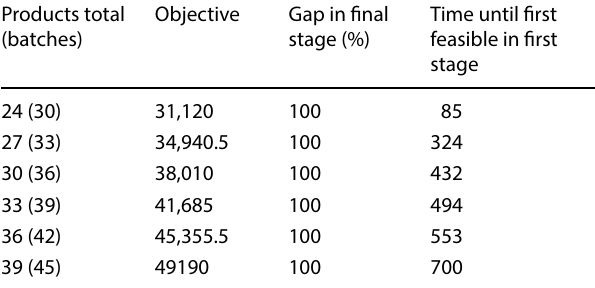
Table 9 Modeling results for input data in Table 4 and procedure in Table 6 Products total